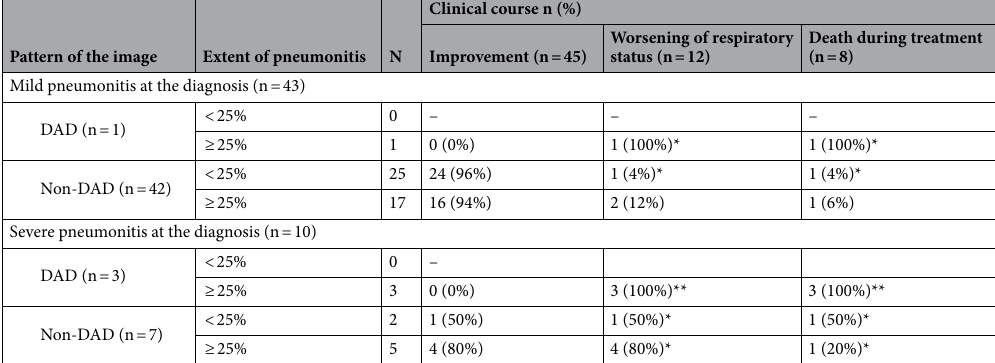
Clinical course n (%) Worsening of respiratory Improvement (n = 45) status (n = 12)